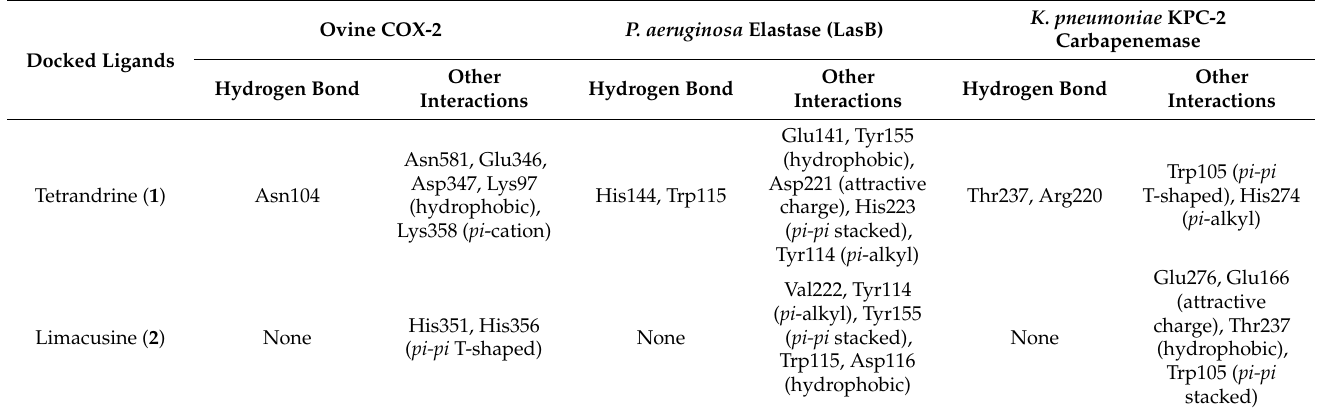
Table 3. Interacting residues between alkaloids 1 and 2 and top target